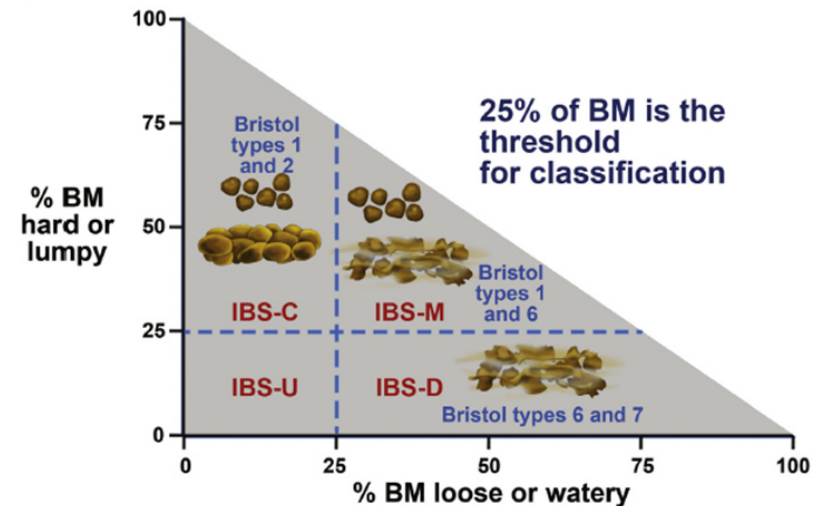
Figure 1. Rome IV criteria for irritable bowel